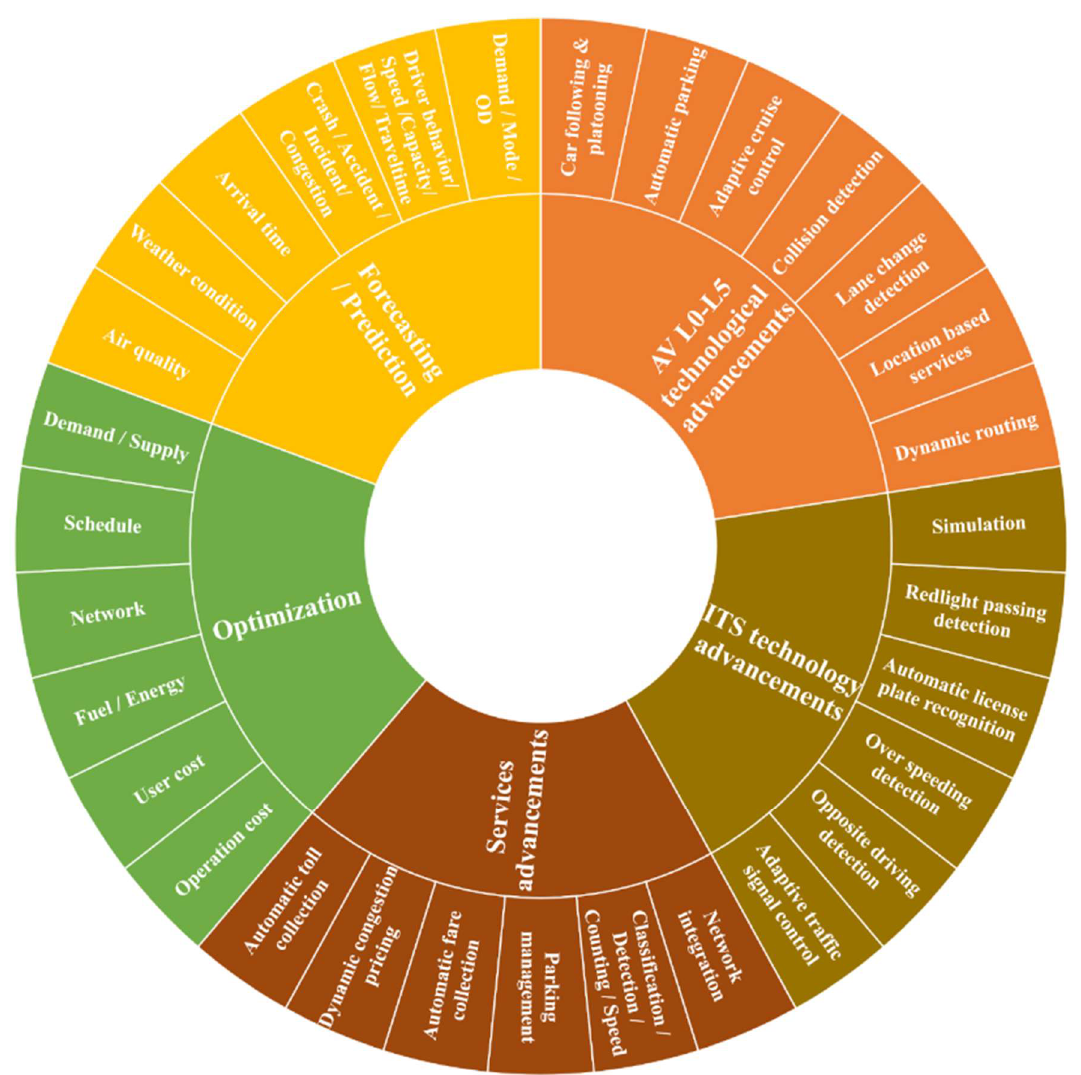
Figure 6. Application areas in STSs.